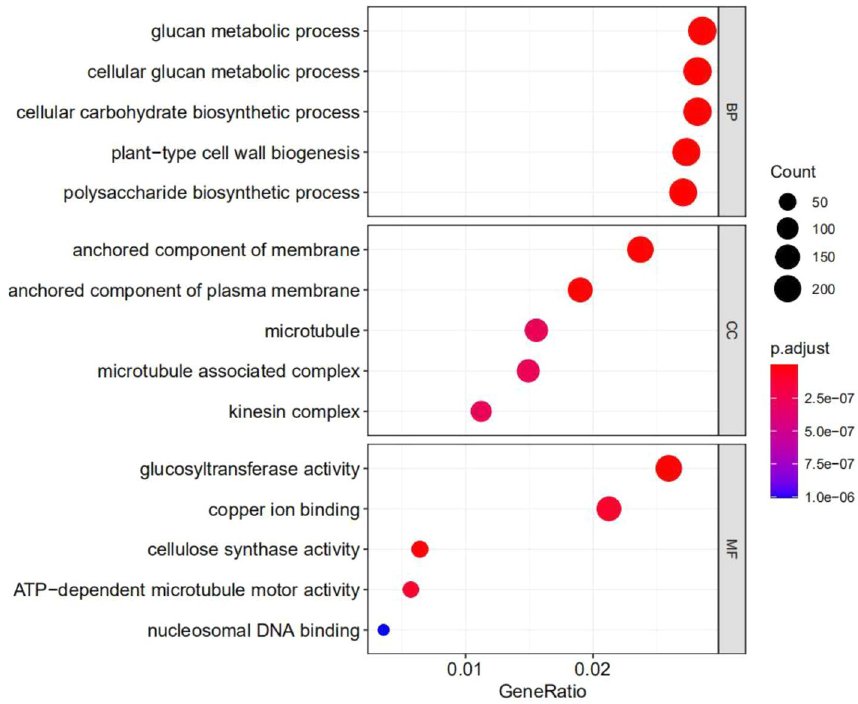
Figure 4. Gene Ontology (GO) term enrichment analysis. An FDR of < 0.05 was used to pick significantly enriched GO